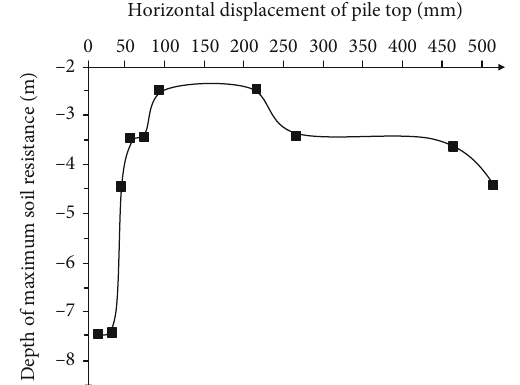
Figure 12: Position of maximum soil resistance in front of pile.